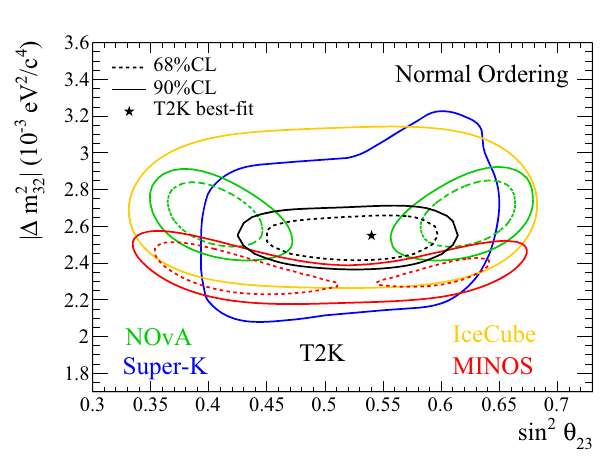
Fig. 73 The 90% confidence level contour in the sin 2 θ 23 − Δ m 2 plane with the reactor constraint in the case of normal mass ordering [62]. Measurements by NOvA [69], MINOS [70], Super-K [71], and IceCube [72] are superimposed